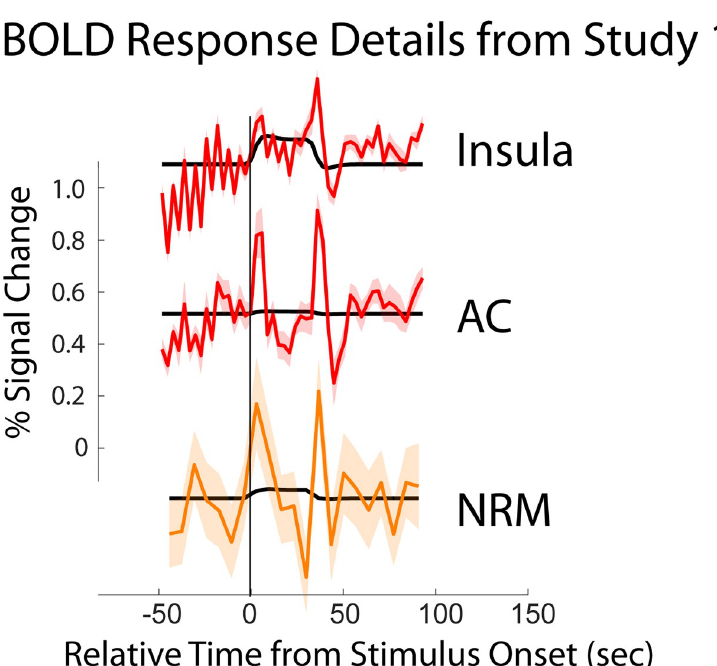
Fig 6. Details of BOLD responses in selected regions from Study 1. The three plots are offset vertically for clarity. The vertical axis indicates the relative scale for each of the 3 plots. The horizontal axis indicates time, with the origin at onset of stimulation. The vertical line indicates when participants were informed of which type of stimulation to expect in Study 2. Lines plotted in red are from brain fMRI data, and the line plotted in orange is from BS/SC data. The fit model paradigm to each time-series response is also shown in black on each plot.